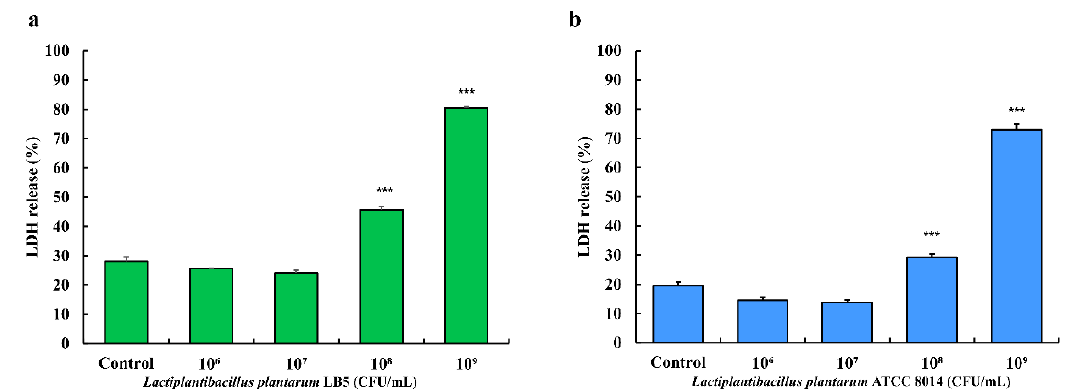
Figure 7. Antioxidant activity of LPLB5 and L. plantarum ATCC 8014. ( a ) 2,2-diphenyl-1-picryl-hydrazyl (DPPH) and ( b ) 2-azino-bis-(3-ethylbenzothiazoline-6-sulfonic acid (ABTS) radical scavenging activities were determined. The results represent the mean ± SEM, with n = 3. * indicates a significant difference vs. control (* p < 0.05).